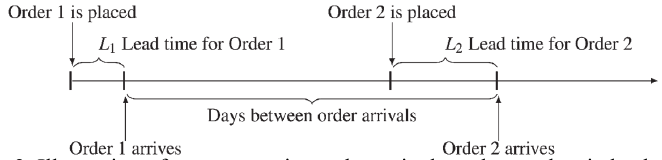
Fig. 2. Illustration of two successive order arrivals under stochastic lead